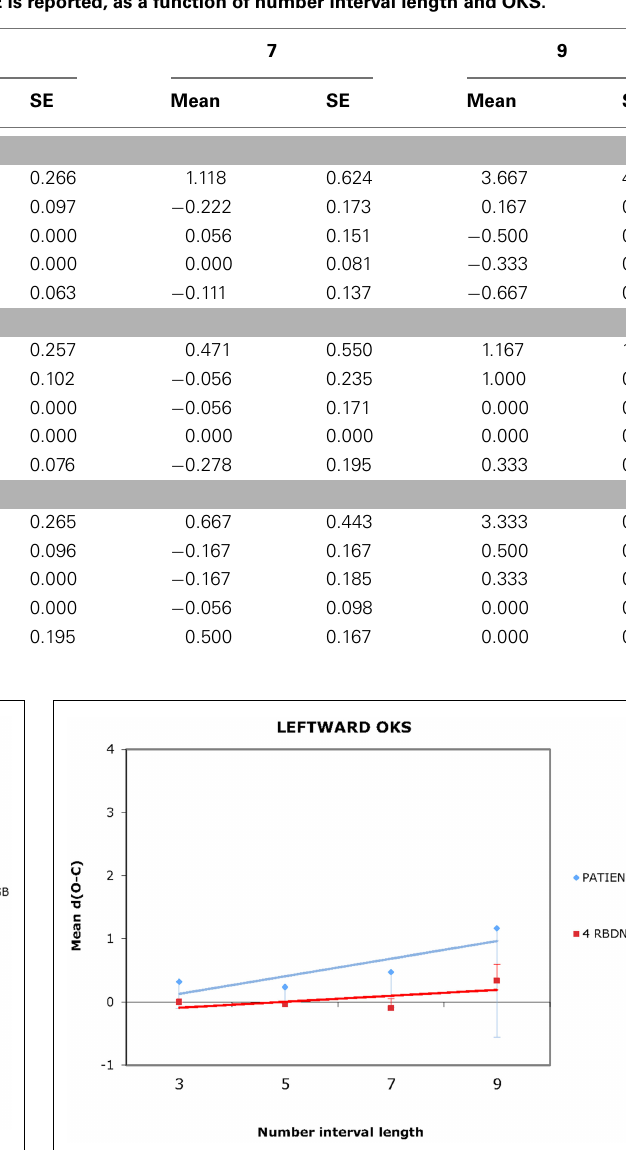
FIGURE 2 | In the leftward OKS condition, BG bisection did not differ from that of controls. Even for length 9 the mean dO–C of RBDN – did not differ from 0, t (3) = 1.663, p =